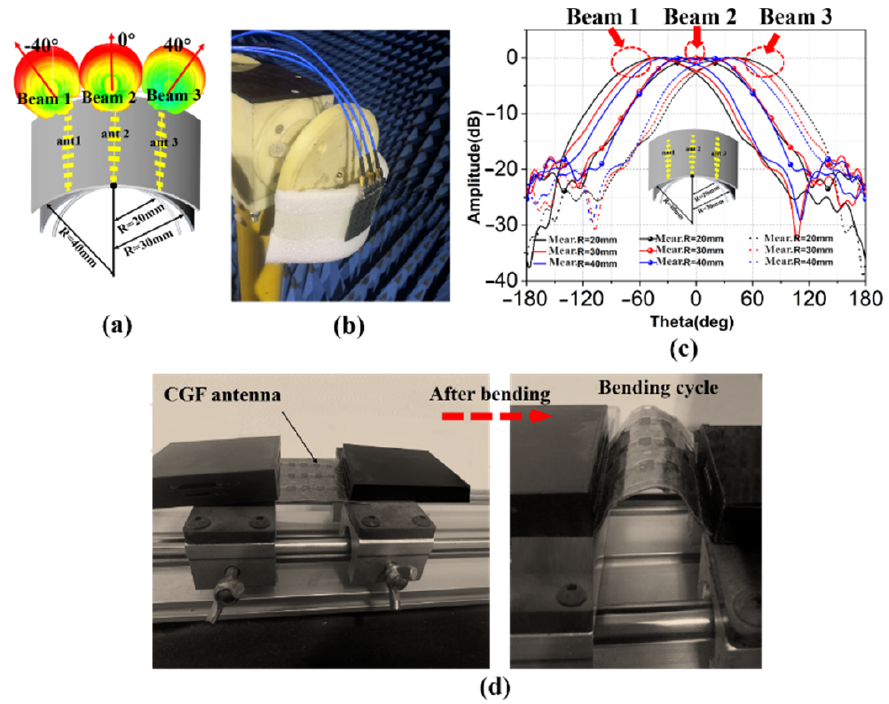
Figure 5. Measurement results: ( a ) conformal CGF antenna on the cylinder with different radii; ( b ) far-field measurement environment; ( c ) yoz-plane radiation patterns; ( d ) bending cycle experi-